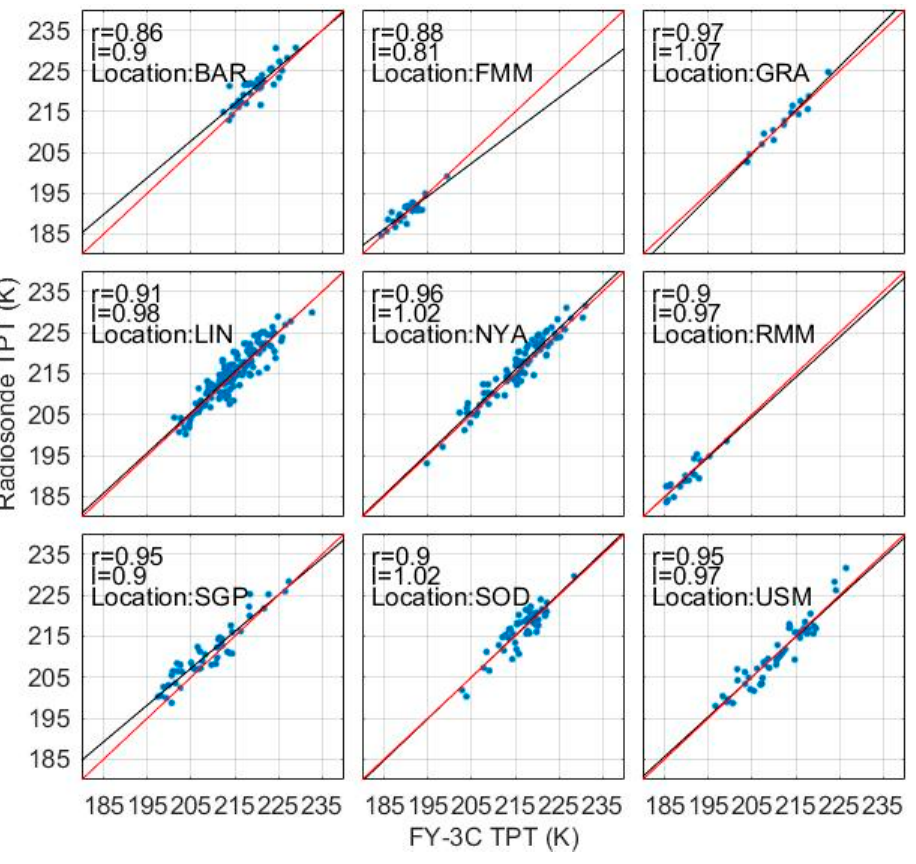
Figure 8. TPT comparison results, which are similar to Figure 7.